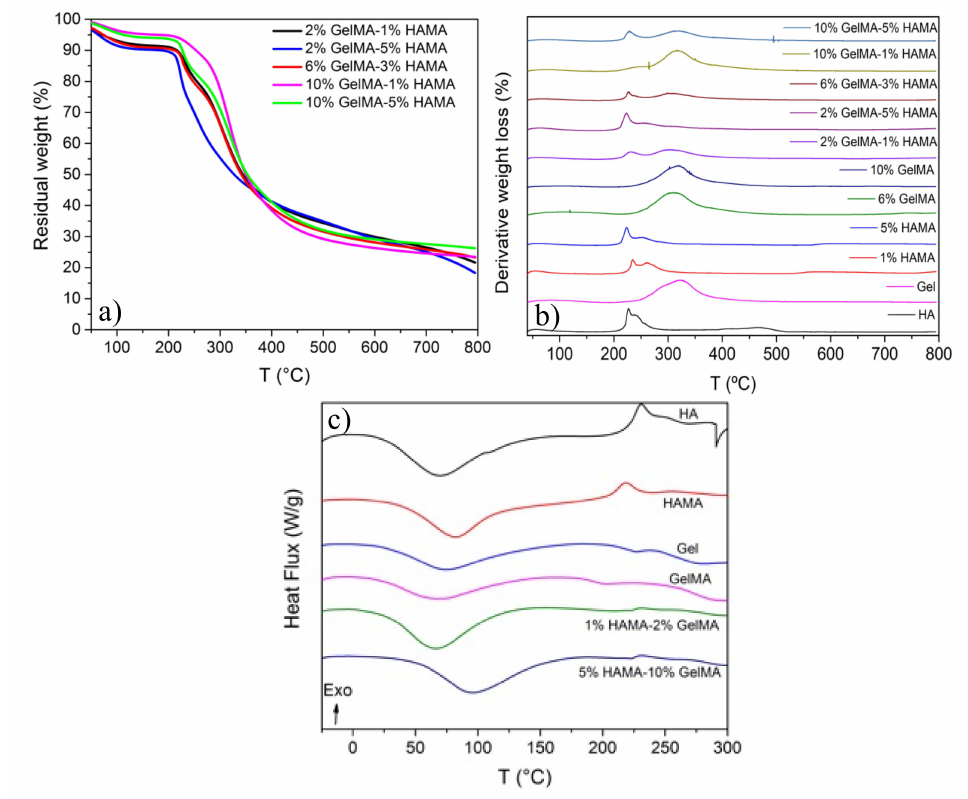
Figure 3. TGA scans of ( a ) hybrid GelMA/HAMA hydrogel scaffolds at different concentrations; ( b ) first derivative plots of TGA data of different pure and hybrid hydrogels; ( c ) examples of DSC curves corresponding pure Gel, pure HA, pure GelMA, pure HAMA, and some hybrid GelMA/HAMA hydrogel